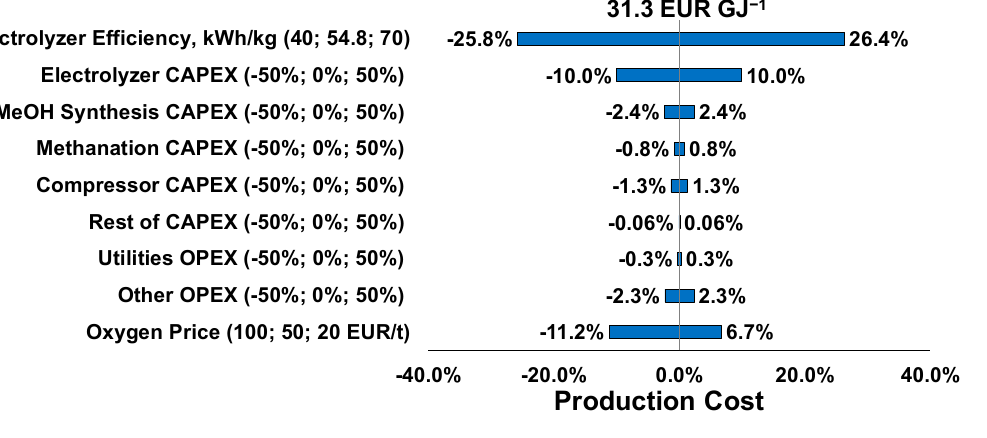
Figure 19. Sensitivity analysis of different cost components of the combined case.